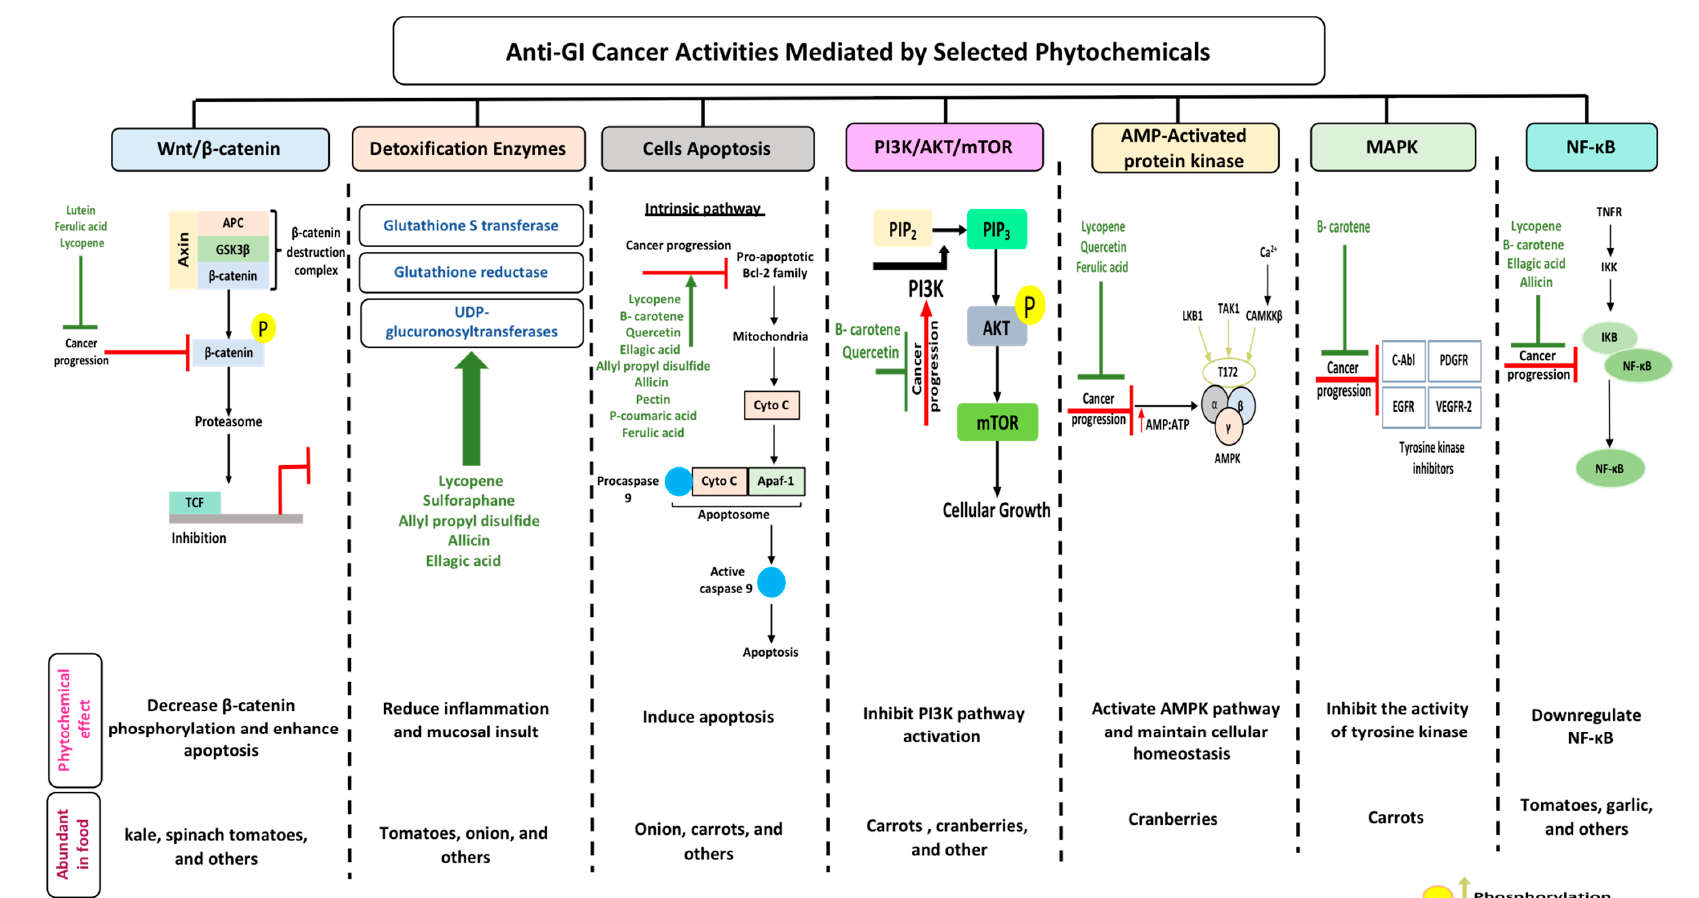
Figure 2. Phytochemicals as anti-GI cancer agents: mode(s) of action, aberrant signaling pathways (Wnt/ β -catenin, detoxification enzymes, cellular apoptosis, PI3K/AKT/mTOR, AMPK, MAPK, and NF- κ B), and pathway components targeted by phytochemicals (highlighted in green). Phytochemicals have a wide range of anti-cancerous actions through which one could target multiple mechanisms. These phytochemicals can enhance or suppress (green and red lines, respectively) the mechanisms through several activities. (see text for detailed mode(s) of action for phytochemicals mentioned).